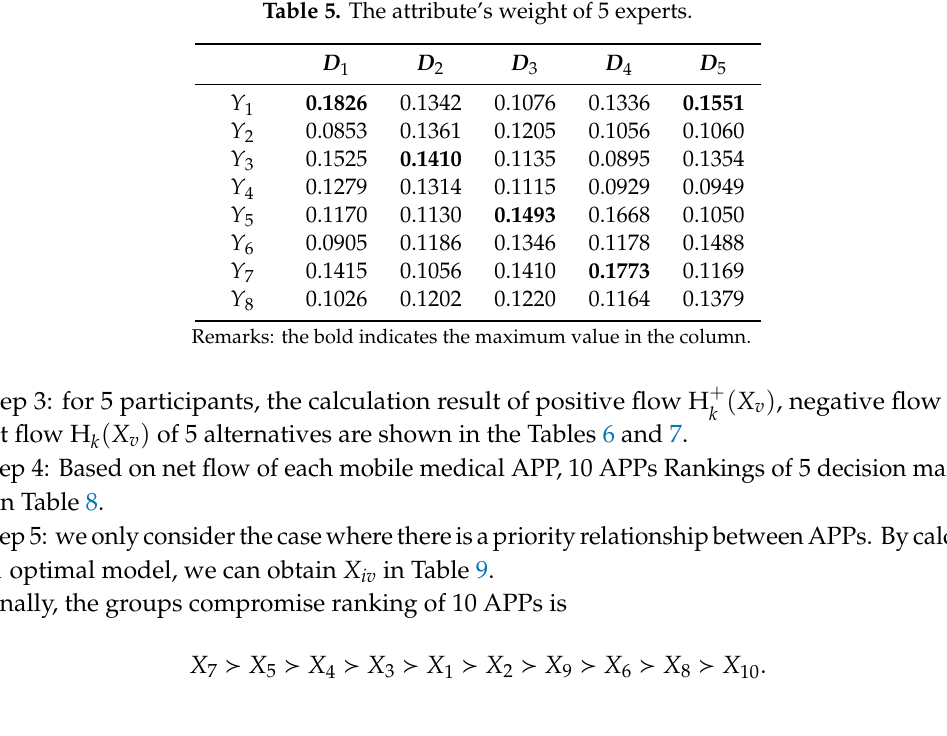
Table 6. The positive, negative and net flow of X v for D 1 , D 2 , D 3